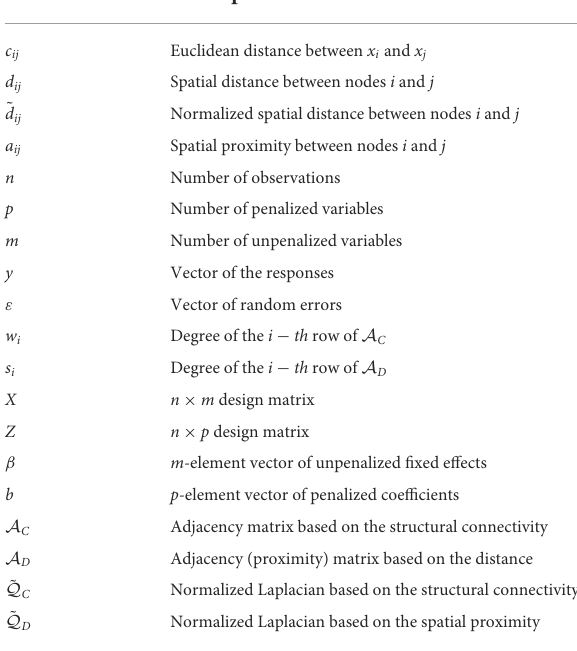
TABLE 1 Notation used in the